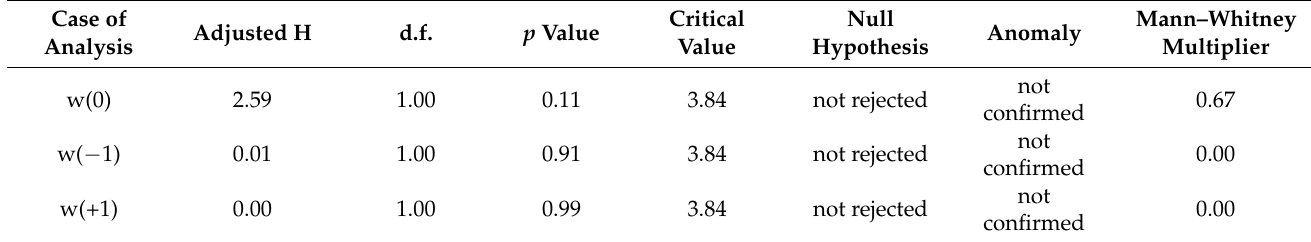
Table A10. T-test of the expiration price effects.